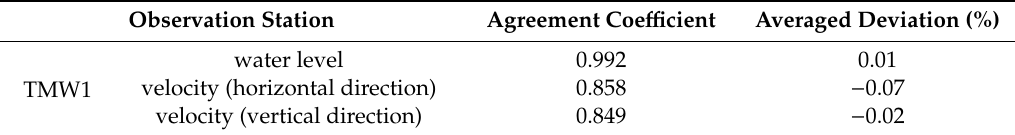
Figure 13. Comparisons of water level and velocity between numerical model and observations at TMW1 station (refer to Figure 12 for location map). Table 4. Statistical results of the quantitative verification at TMW1 station .